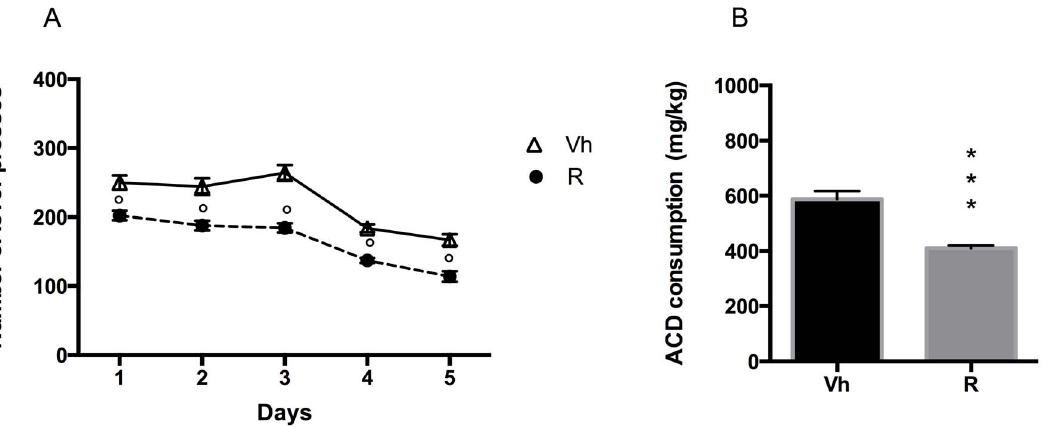
Figure 5. Ropinirole and Relapse. Number of lever presses in Vh and R groups during Relapse following 1 week abstinence. u p , 0.001 Vs Vh (A). ACD consumption (mg/kg) during Relapse following 1 week abstinence. ***p , 0.001 Vs Vh (B).